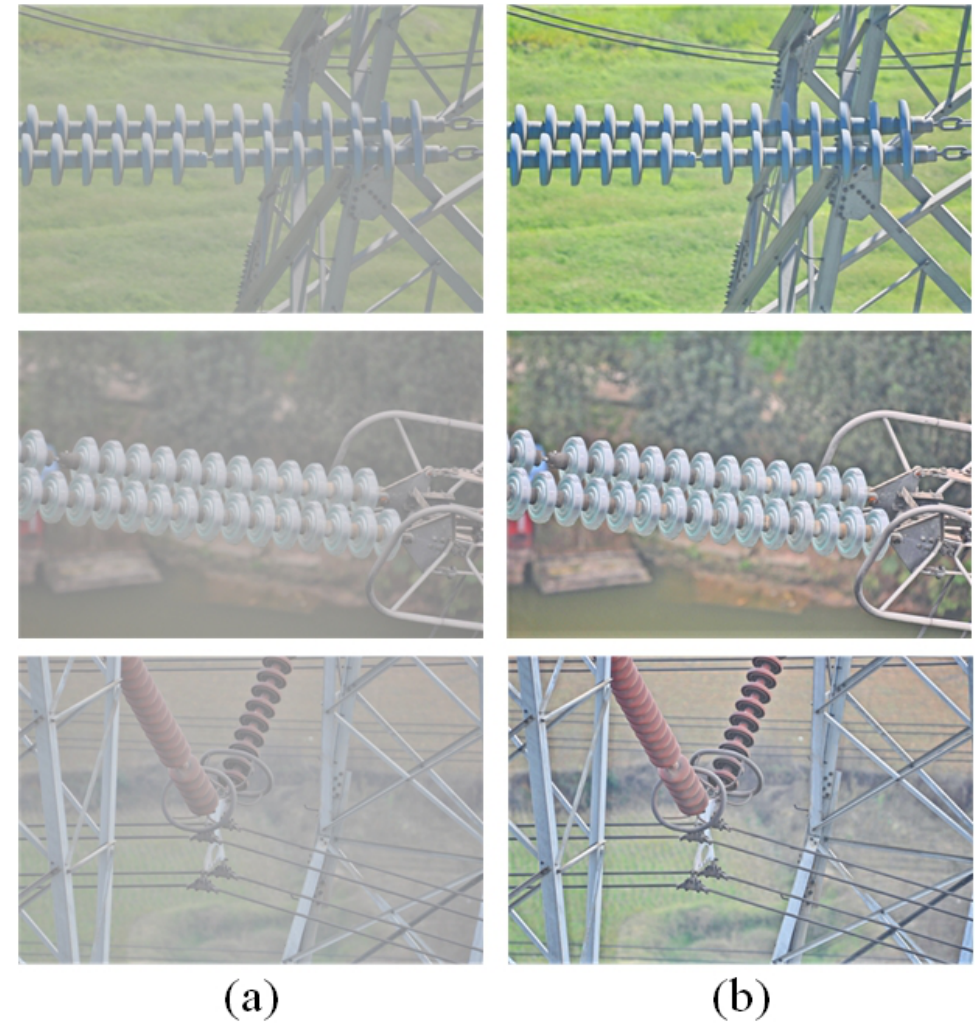
Figure 11. Visualization of Dehazing Algorithms. ( a ) Foggy images. ( b ) Images after